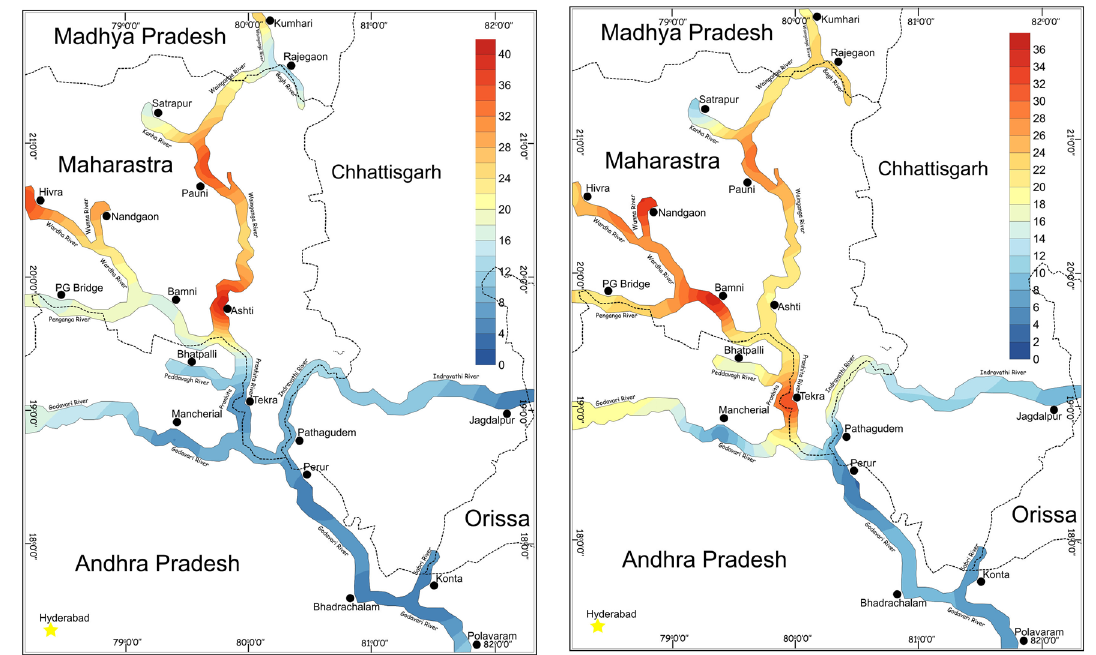
Fig. 3 Contour map showing Cu and Ni concentrations (Sept. 2011 to Aug.